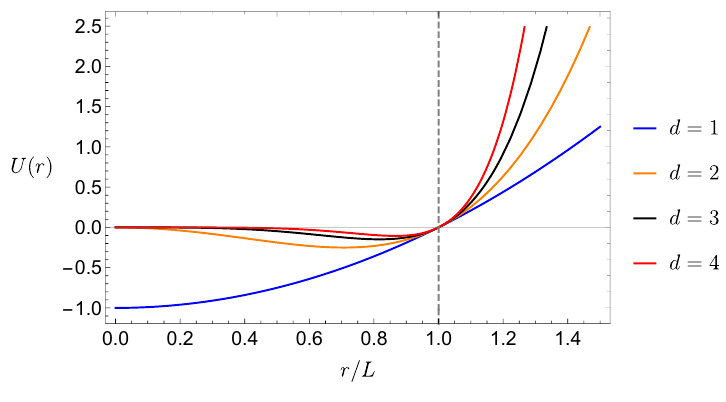
Figure 10 . The effective potentials U ( r ) for the extremal surfaces in dS d +1